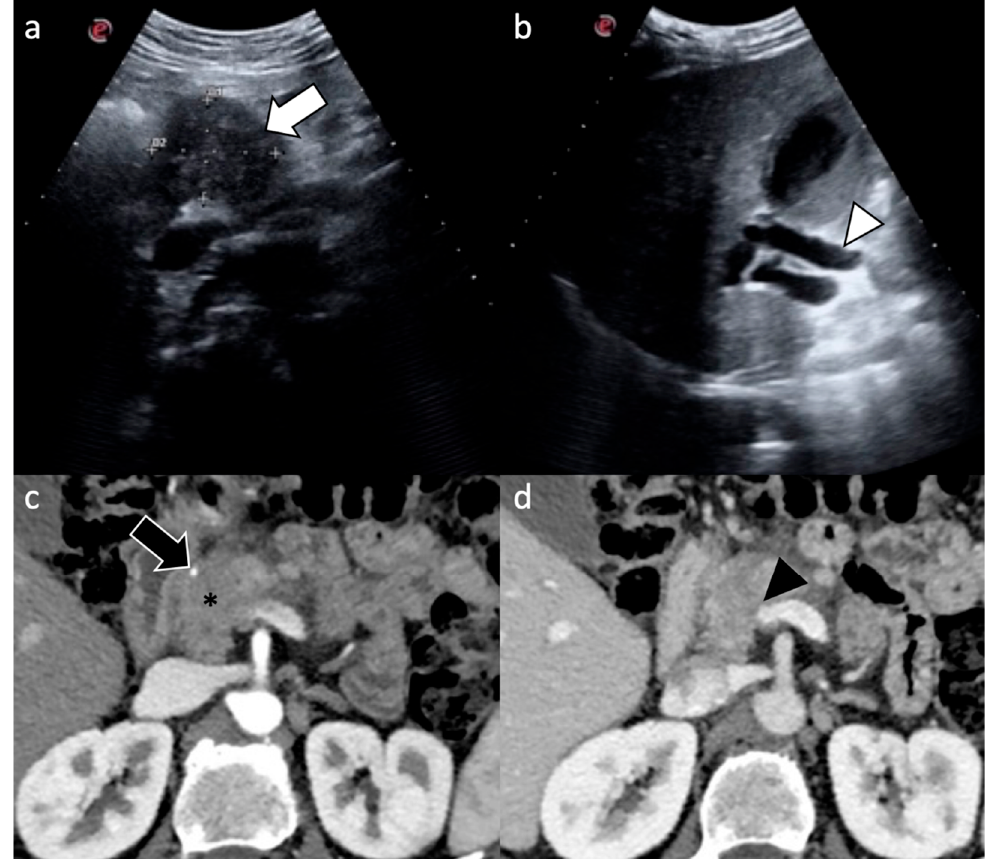
Figure 1. A 57-year-old man who came to the emergency department for jaundice and abdominal pain. ( a , b ) US detected a mass in the pancreatic head (white arrow) causing upstream dilatation of the common bile duct (white arrowhead); ( c , d ) Pancreatic CT scan confirmed the presence of mass in the pancreatic head (*) that caused encasement of the gastroduodenal artery (black arrow) as well as encasement and narrowing of the superior mesenteric-portal venous confluence (black arrowhead), the superior mesenteric vein, and the portal vein.